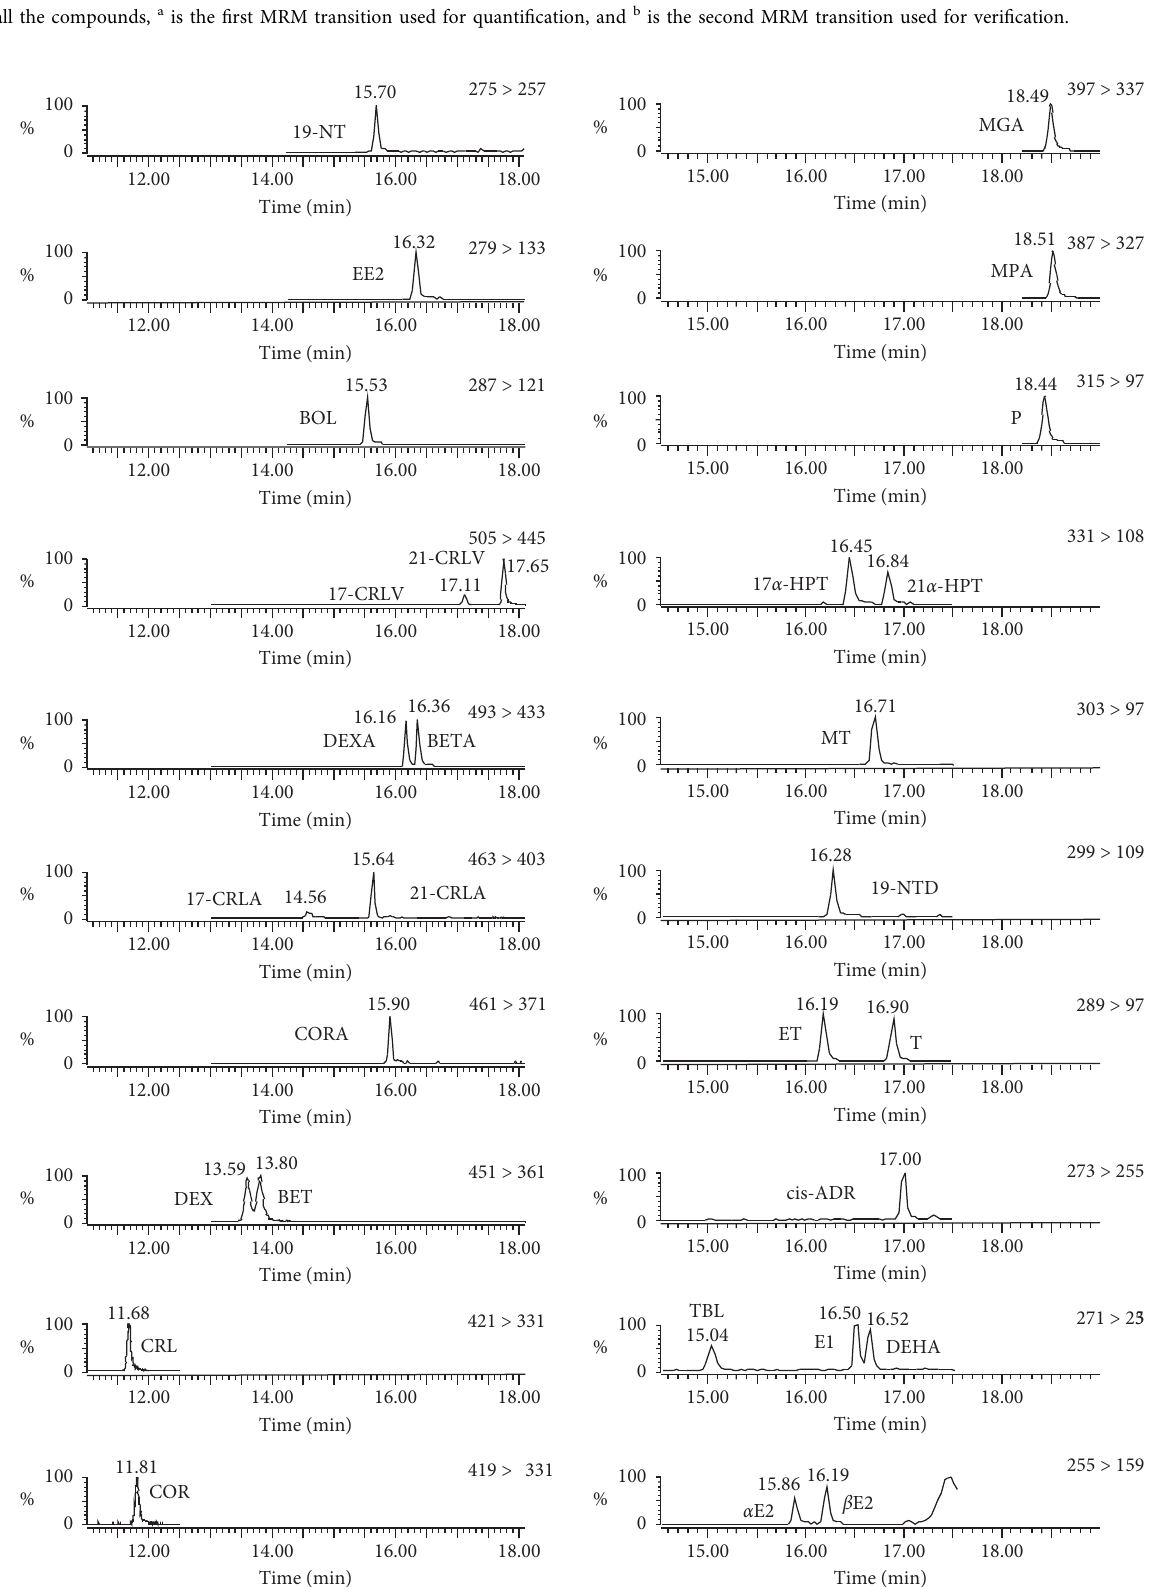
Figure 1: UPLC-MS/MS MRM chromatograms of target